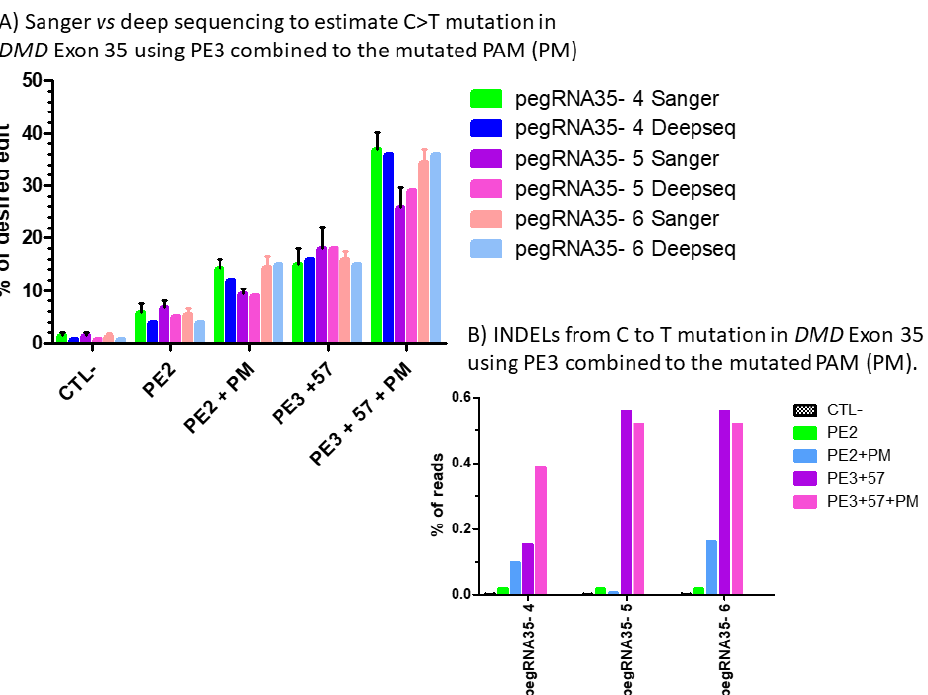
Figure 8. ( A ) Sanger vs. deep sequencing to estimate the percentage of C to T mutations in DMD exon 35 using PE3 combined with the mutated PAM (PM). The percentages of modification estimated by the Edit R program using the average Sanger sequencing results were not different for those obtained with CRISPRESSO using the Illumina deep sequencing results for the pegRNA 4, pegRNA 5 and pegRNA6. ( B ) Indel level from prime editing of DMD exon 35 using the PE3 strategy combined with the mutation in the PAM (PM): deep sequencing results. There were no Indels in the control sample. The Indel levels ranged from 0 to 0.16 and from 0.1 to 0.56% for PE2 and PE3 strategy, respectively, using pegRNA35-4, pegRNA35-5 and pegRNA35-6.